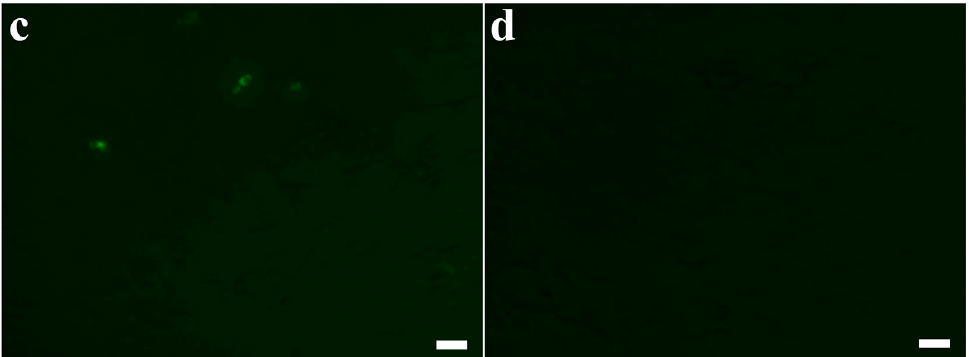
Figure 3. Reactive oxygen species (ROS) generation of Trx-H proteins and their swapped proteins in C. albicans . Cells were treated with the proteins at their MIC concentrations in pH 5.2 for 8 h, after which they were stained with 100 µM DCF-DA for 1 h. Cells with ROS generation were visualized by fluorescence microscope. ( a) : Trx-H2, ( b) : Trx-H3, ( c) : Trx-2N3C, ( d) : Trx-3N2C. Scale bar: 10 µm.